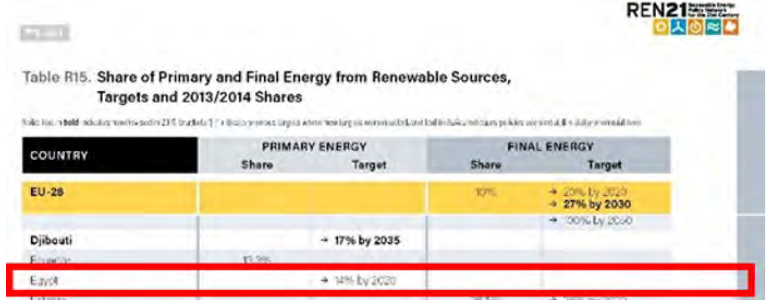
Figure 12. (GRS Full report 2016 )